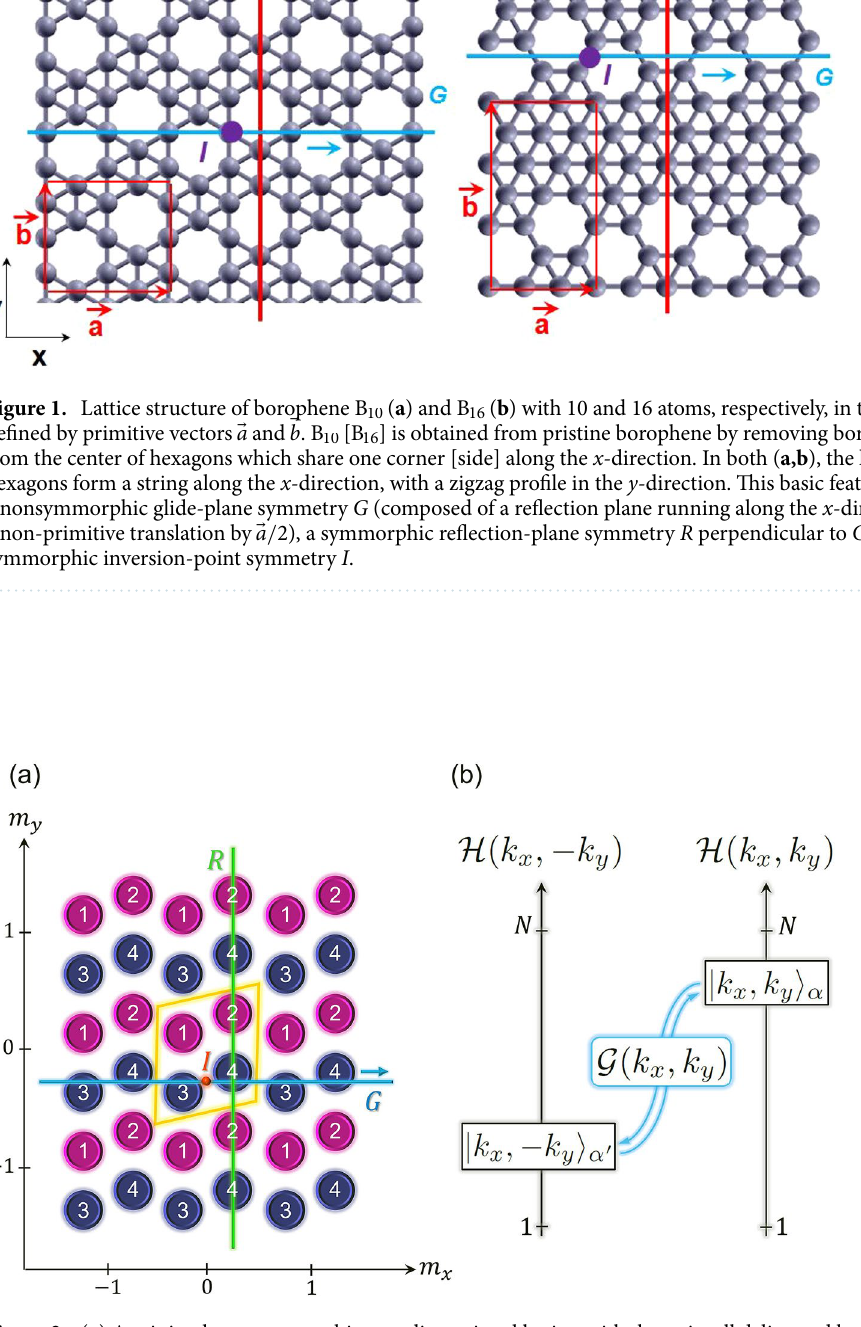
Figure 2. ( a ) A minimal nonsymmorphic two-dimensional lattice, with the unit cell delineated by the yellow lines. The location of the unit cell is defined by ( m x , m y ) . The disks numbered from 1 to 4 represent two types of structures within the unit cell. In real borophenes B 10 and B 16 shown in Fig. 1a,b, these structures are the hollow and filled pieces that make up the unit cell of those materials. The minimal lattice has the following spatial symmetries: a nonsymmorphic glide plane, G , composed of a reflection about the m x -direction, followed by a nonprimitive translation by half of the length of the unit cell along the m x -direction, a symmorphic reflection r on the lattice to r . plane, R , about the m y -direction, and a symmorphic inversion point, I , which takes a point (cid:31) −� k x , k y ( b ) The glide-plane symmetry G ( k x , k y ) transforms the eigenstate of the Bloch Hamiltonian H ( k x , k y ) | � α 4 for the lattice k x , k y k y ) , and vice-versa. N is the number of bands ( N into the eigenstate of H ( k x , | − � α ′ − = depicted in ( a